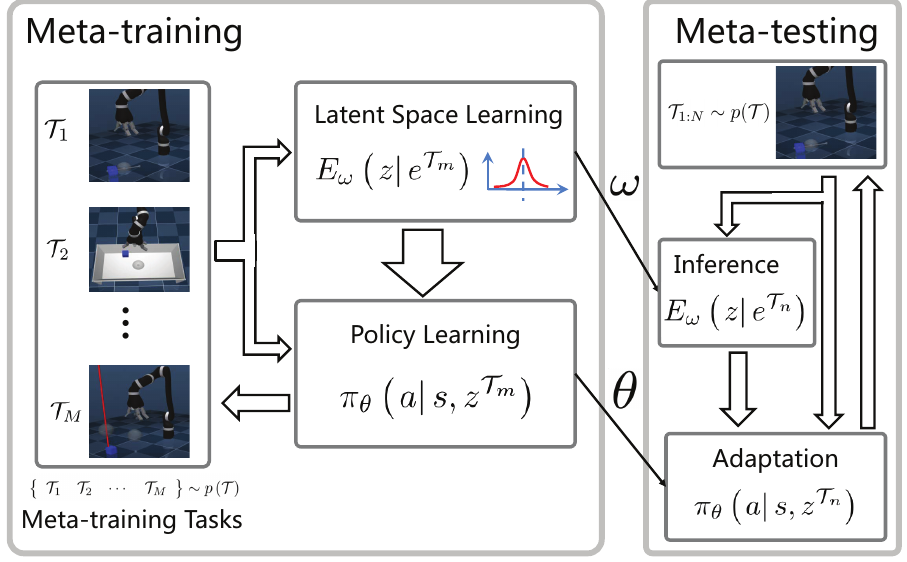
Figure 1. Latent space-based robotic skill transfer learning